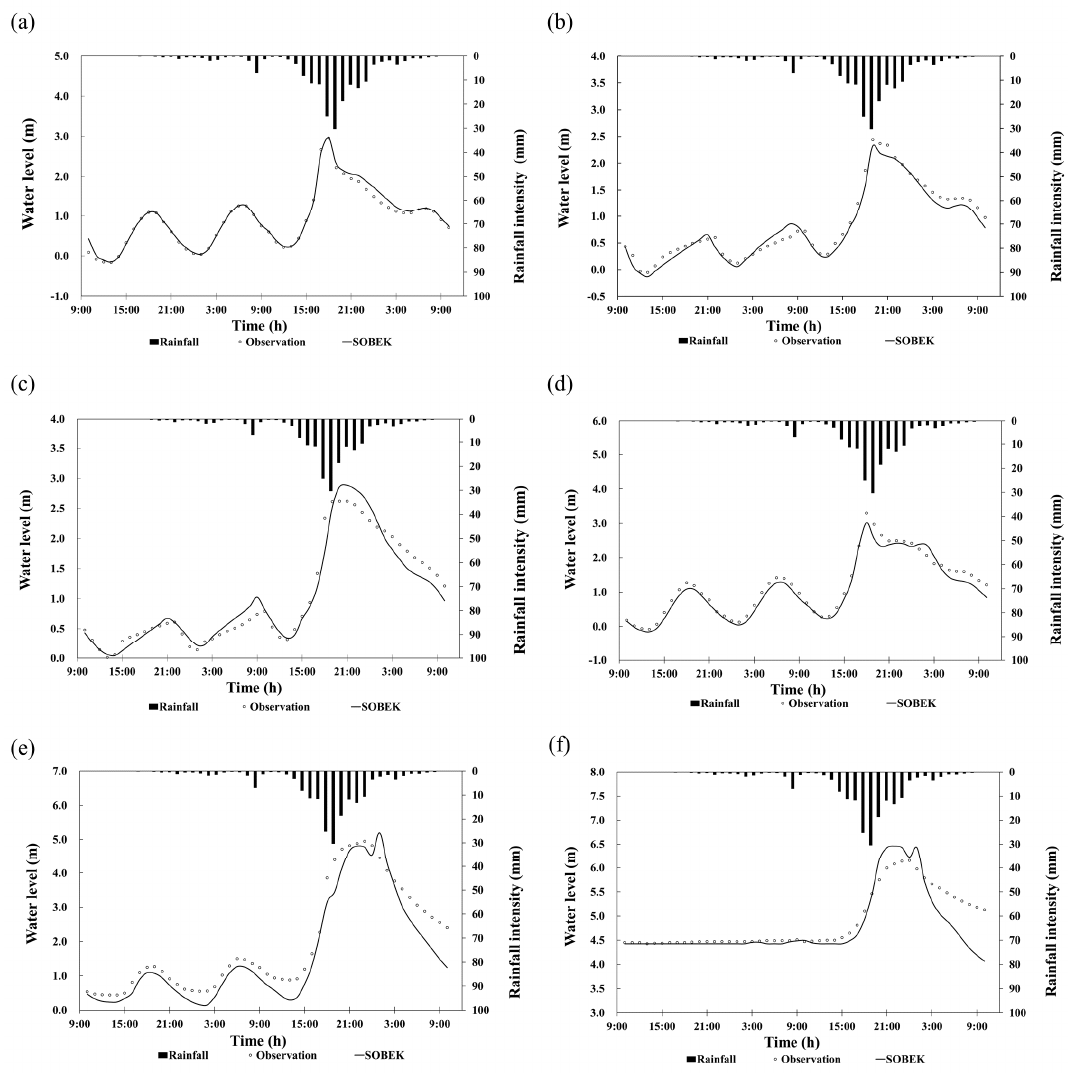
Table 2. E Tp , E Wp , CE and RMSE values for the water level: simulated results by SOBEK model.